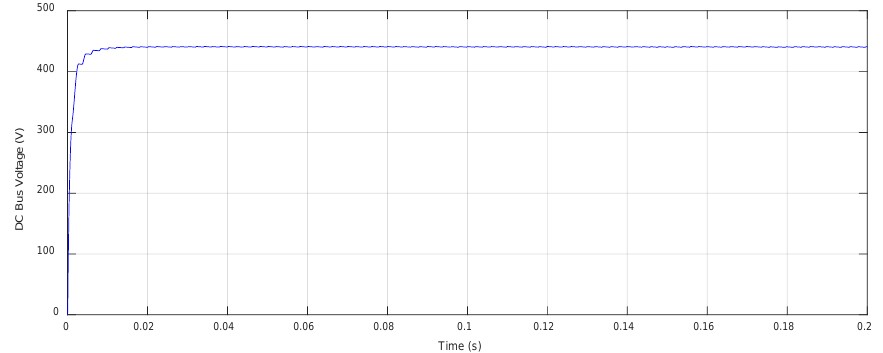
Figure 5. DC bus voltage during the 0.2 s simulation without faults.